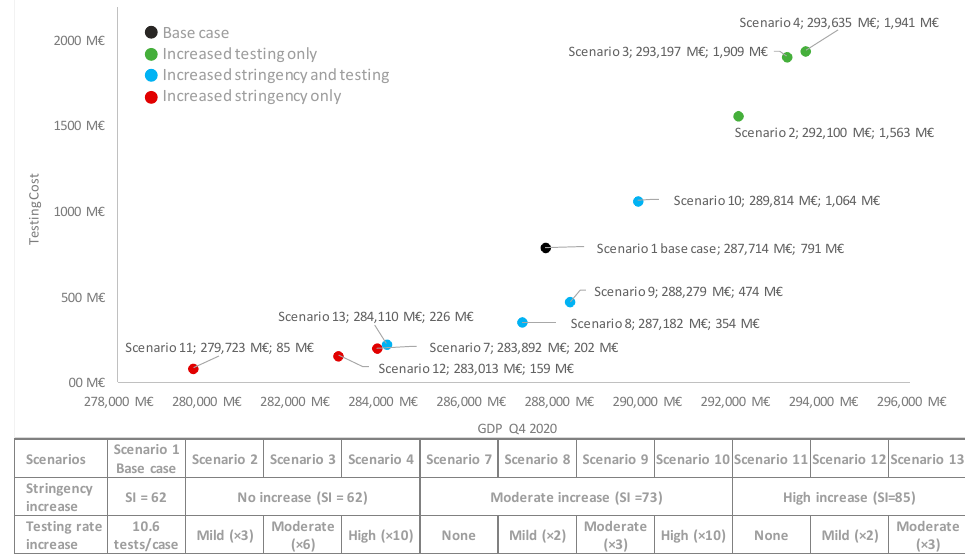
Figure 7. Costs of testing and GDP impact for each scenario . M€: million €; SI: Stringency Index.